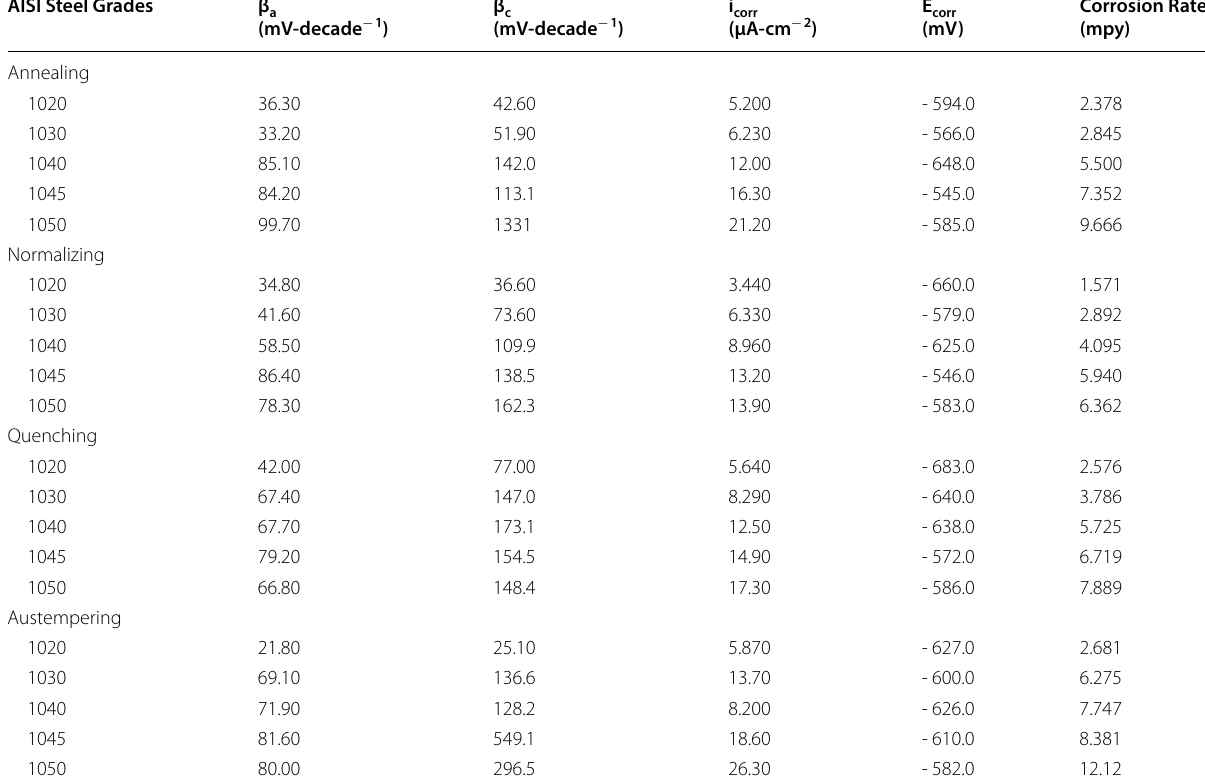
Table 3 Kinetic parameters calculated from Tafel scan of all heat-treated plain carbon steels AISI Steel Grades